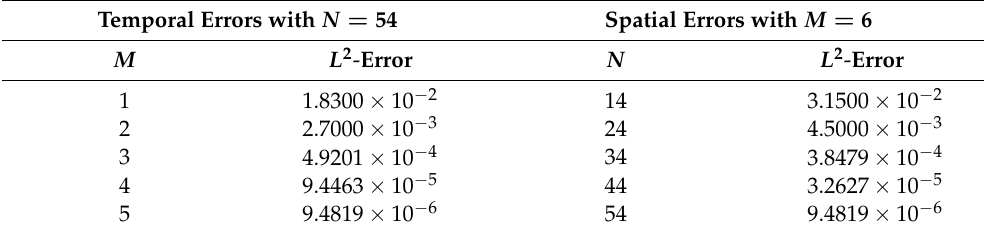
Table 5. Spectral errors at t = 1 for Example 3. Take a = − 12, b = 12, κ = 1, x 0 = 0. Temporal Errors with N = 54 Spatial Errors with M =